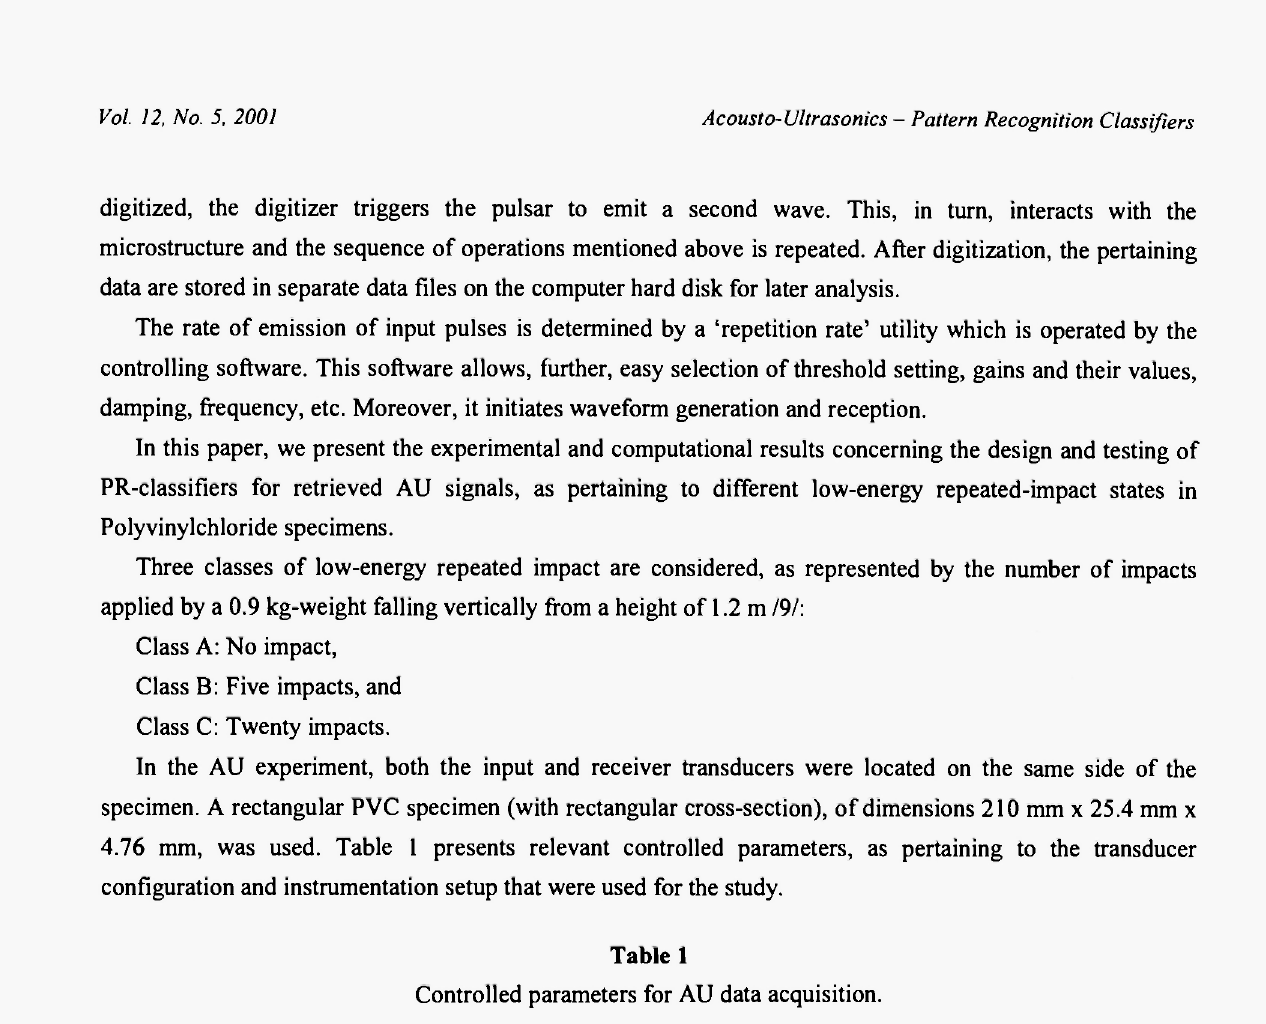
Controlled parameters for AU data